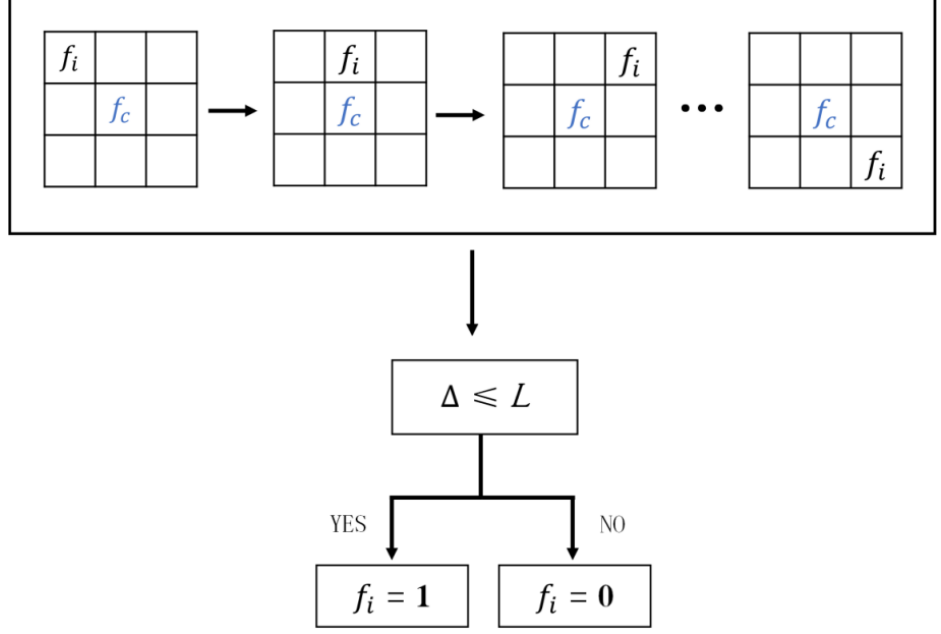
Figure A1. Binarization diagram.